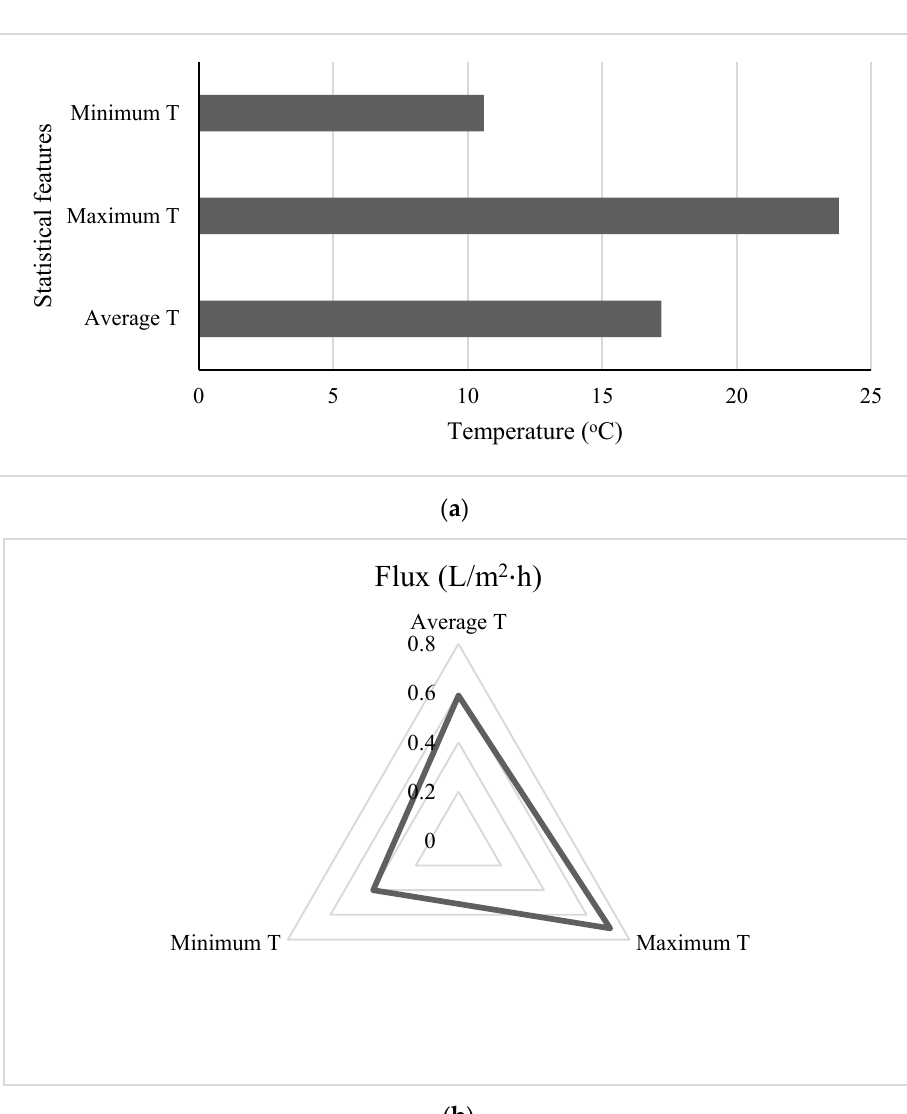
Table 2. ANOVA of the parameters influencing the water production